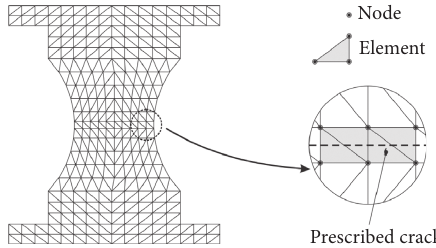
Figure 12: Structured mesh with triangle elements.